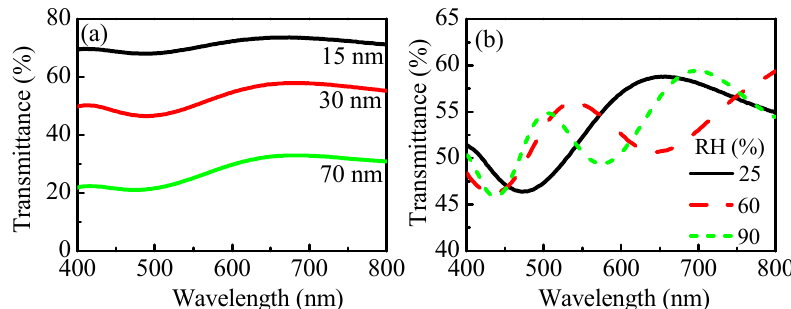
Figure 9. ( a ) Transmittance spectra of Au–Pd films with thicknesses of 15, 30, and 70 nm sputtered on glass substrates and covered with polymer film with a thickness of 300 nm. ( b ) Transmittance spectra of the system polymer (300 nm)/Au–Pd (30 nm)/glass at denoted humidity.